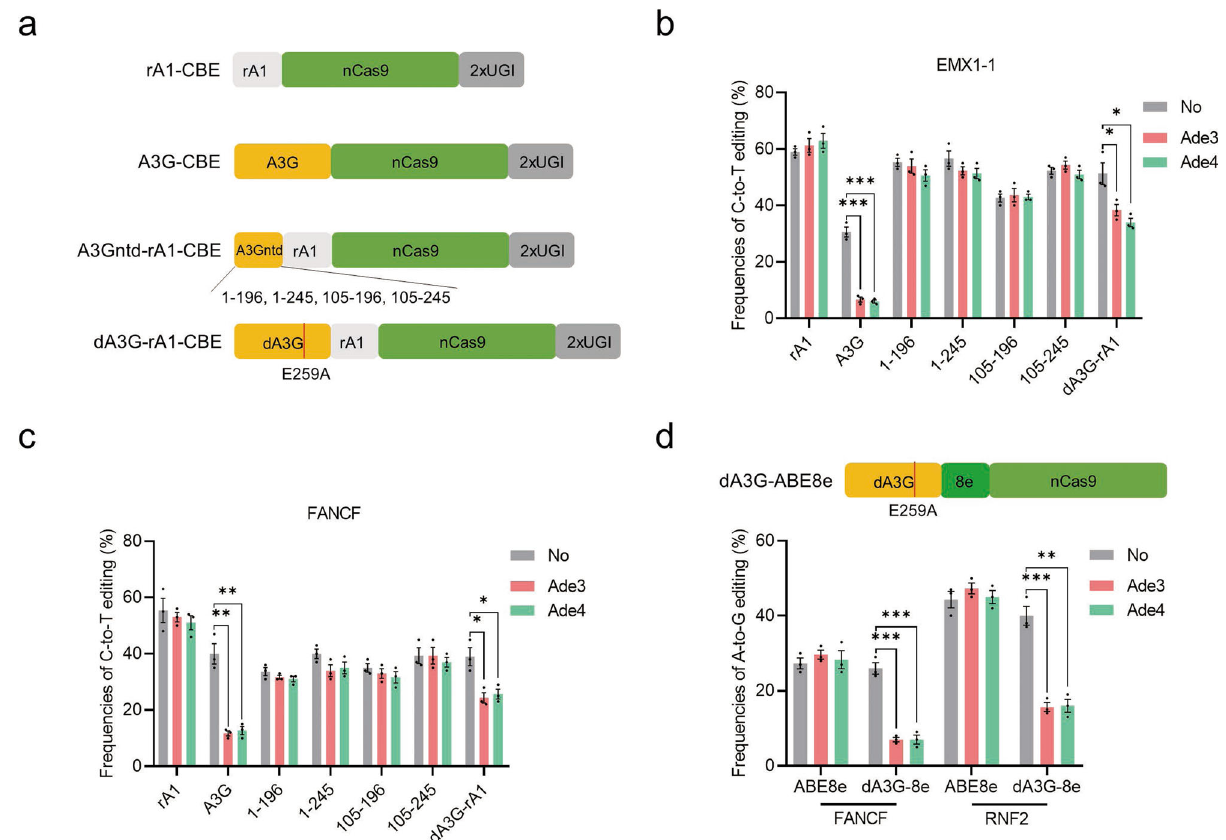
Fig. 4 Expanding the application of Ades to rA1-CBE and ABE8e. a Schematic representation of rA1-, A3G-, A3Gntd-rA1- and dA3G-rA1-CBEs. nCas9, D10A. b , c C-to-T editing of seven CBEs in the presence or absence of Ade3 and Ade4 at the EMX1-1 site ( b ) and FNACF site ( c ). Plasmids expressing CBE, sgRNA, and each Ade (1:1:1) were cotransfected into HEK293T cells. d Top: Schematic representation of dA3G-ABE8e. Bottom: A-to-G editing of ABE8e and dA3G-ABE8e in the presence or absence of Ade3 and Ade4 at the FANCF and RNF2 sites. Values and error bars re fl ect the mean ± s.e.m. and n = 3 biologically independent experiments. All p values were calculated by two-sided t tests. * p < 0.05, ** p < 0.01, *** p < 0.001. Source data are provided as a Source Data fi